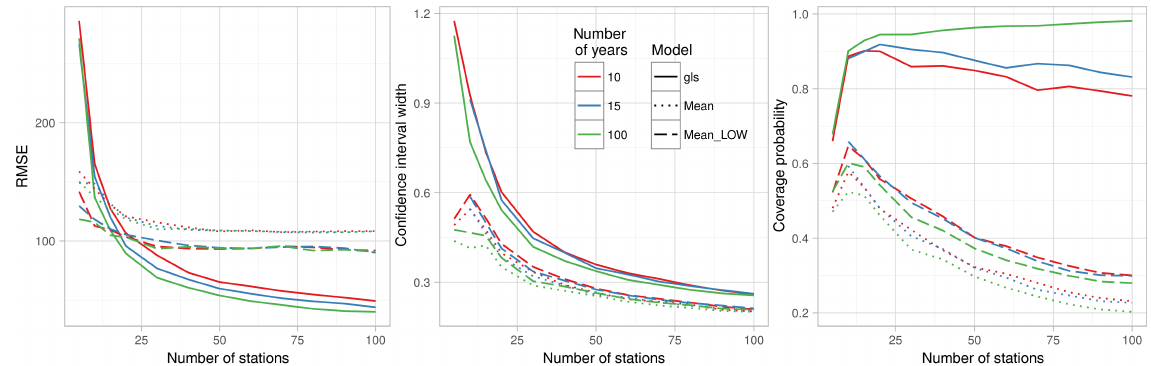
Figure 7. The RMSE, width of the confidence interval, the coverage probability for a GLS model (solid lines), the “areal-average” model considering all stations (dotted lines), and only those below 600m (dashed lines) based on simulated data with various record lengths and number of stations.